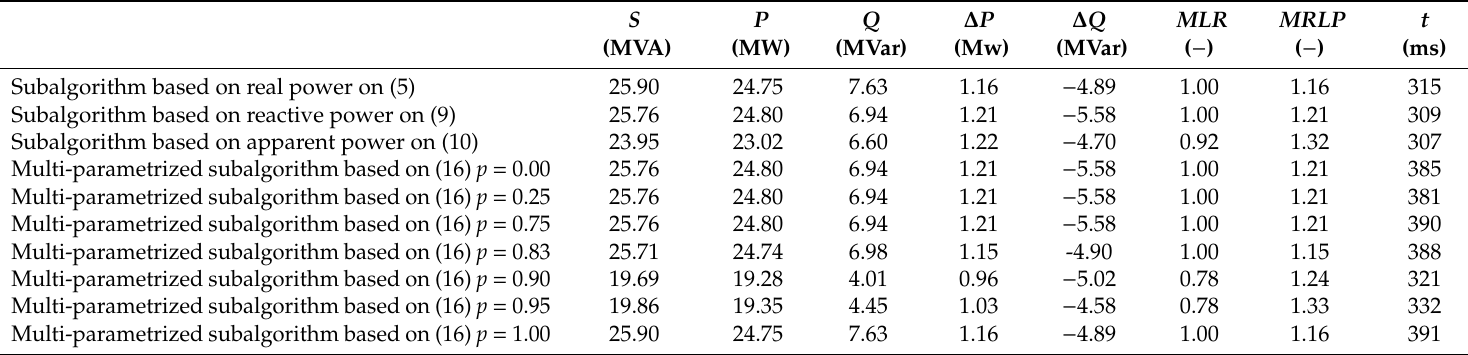
Table 4. Apparent power, real power, reactive power delivered to the considered 20 kV power system’s structure, changes of total real power and of total reactive power.